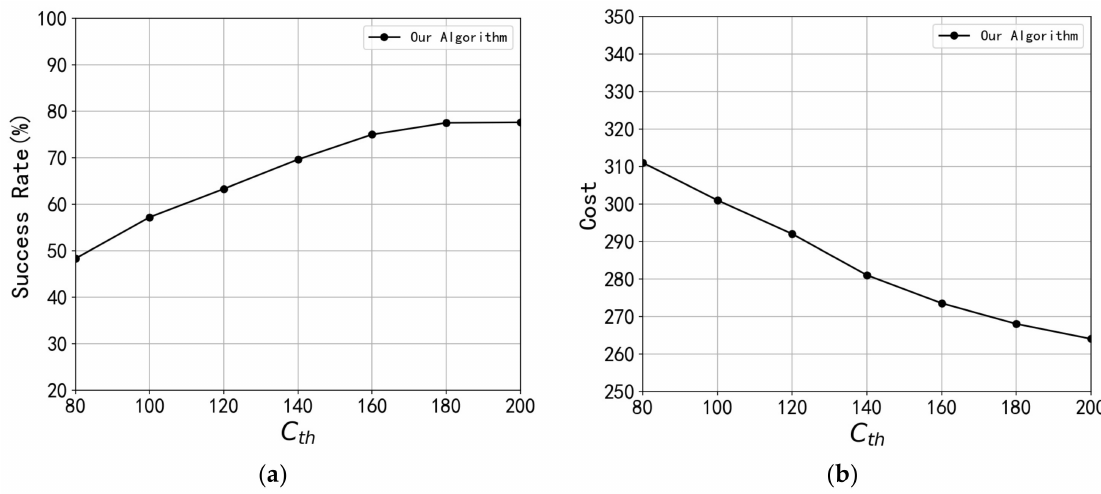
Figure 10. Simulation results with diverse value of C th . ( a ) Task successful rate under C th , and ( b ) execution cost under C th